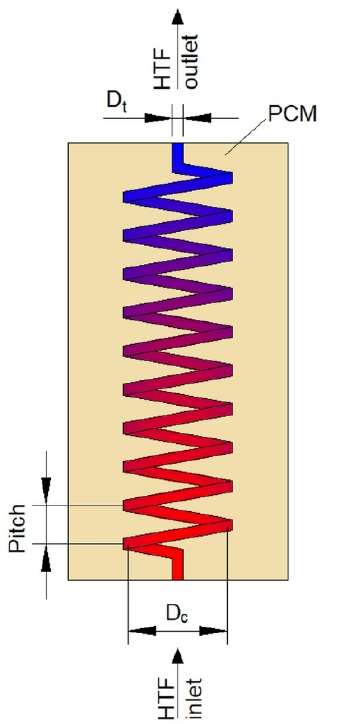
Figure 3. Plate heat exchanger with upward heat transfer fluid (HTF) flow. D c —coil diameter, D t —tube diameter.